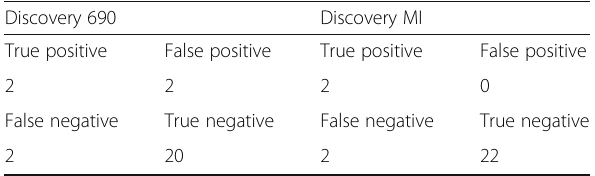
Table 5 Primary lesion — histology compared to metabolic TNM stage Discovery 690